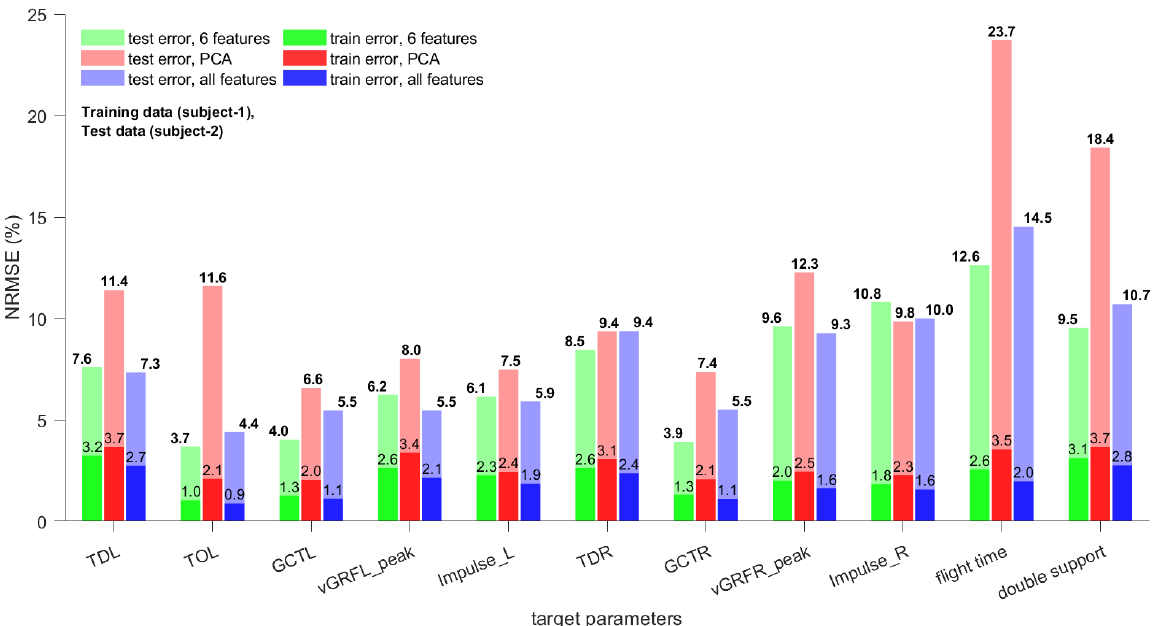
Figure 9. Normalized root-mean square errors of three types of regression models for gait parameter estimates of training set and test set